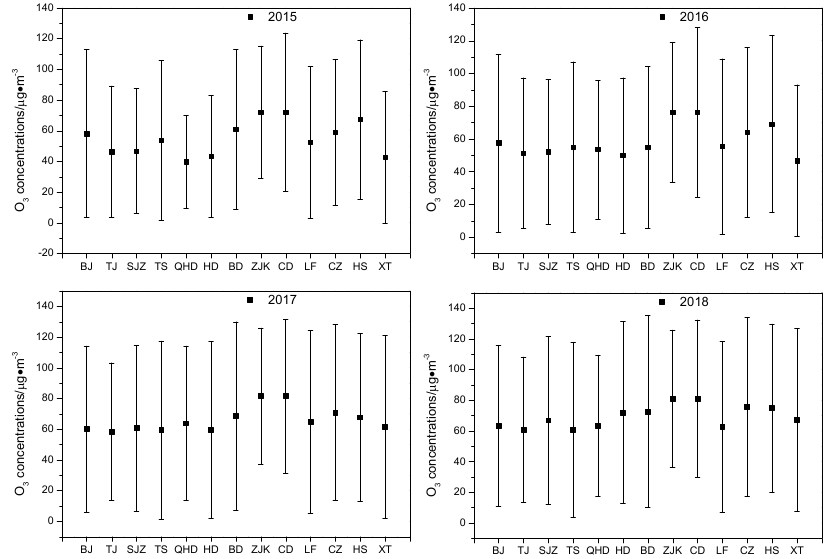
Figure 3. Inter-annual variability of surface ozone (O 3 ) concentrations in BTH area. Figure 3. Inter ‐ annual variability of surface ozone (O 3 ) concentrations in BTH area.